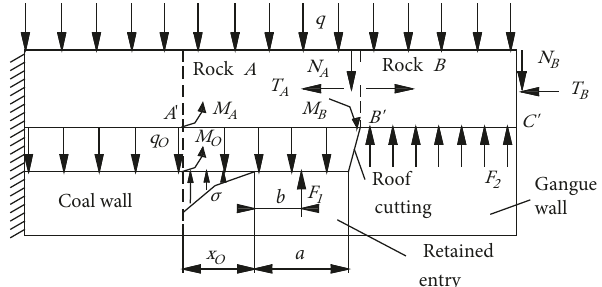
Figure 13: Simplified mechanical model of dynamic pressure